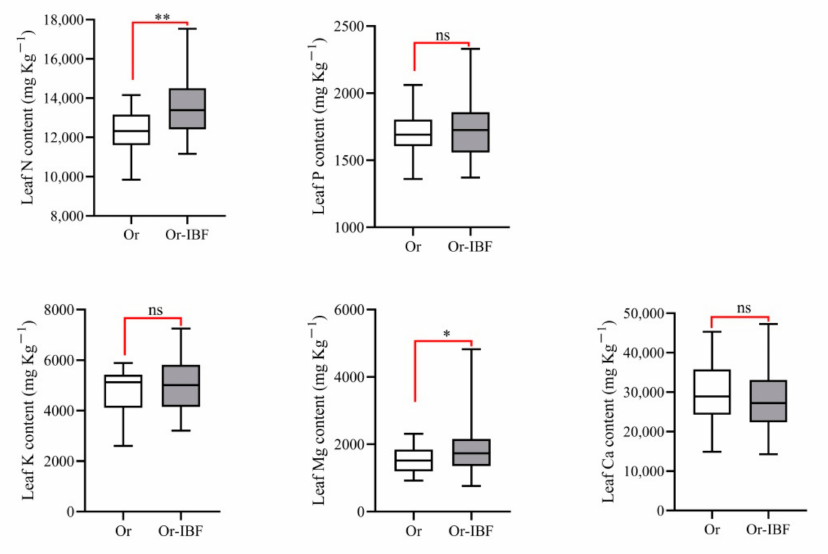
Figure 9. Box plots of leaf N, P, K, Mg and Ca content in the orchard without and with internal flesh breakdown (IFB) fruit. Or and Or-IBF represent 24 mango orchards without IFB fruit and 76 mango orchards with IFB fruit, respectively. Significant differences were determined by one-way ANOVA